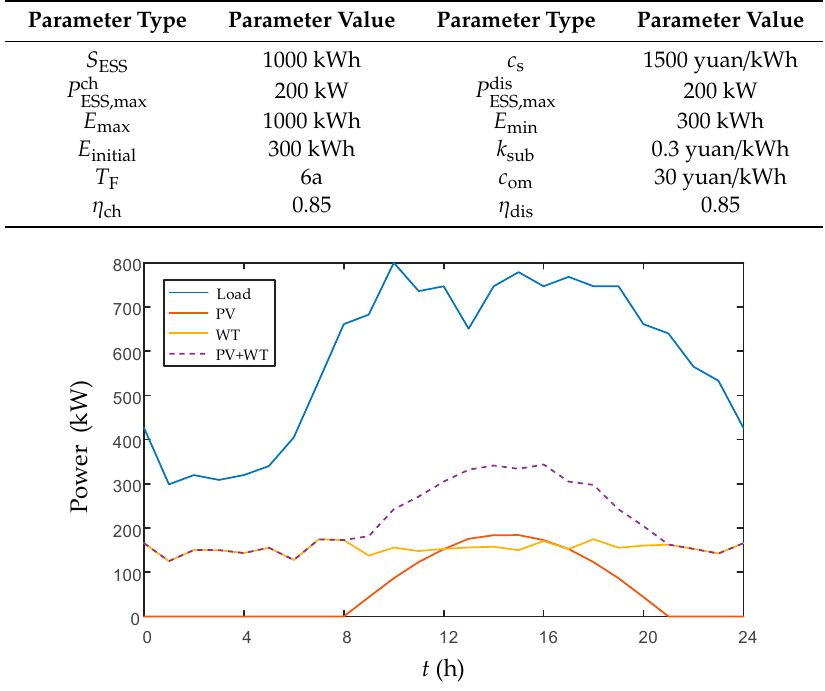
Table 1. Parameters of the energy storage system (ESS).